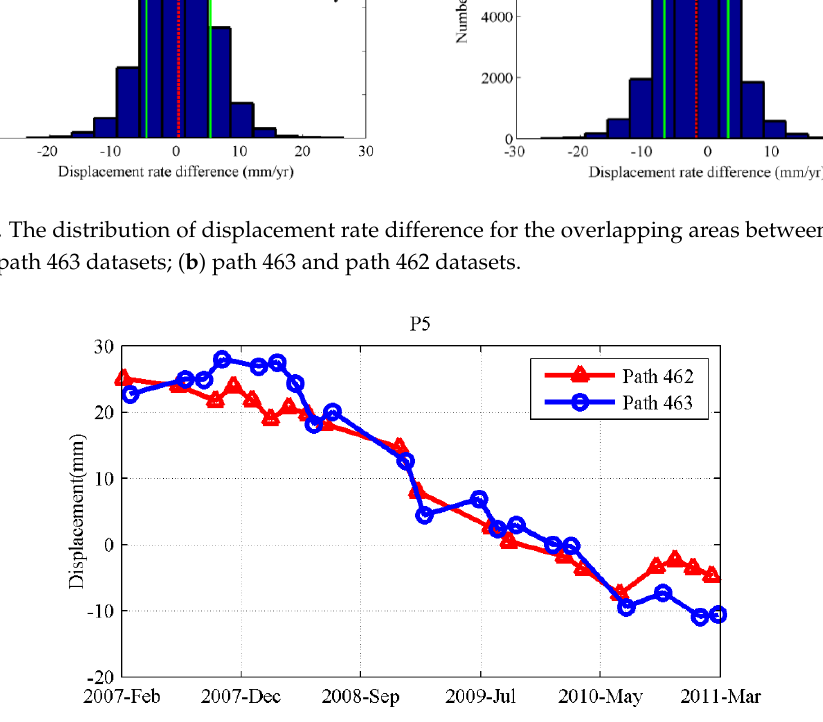
Figure 9. Time series displacement of point P5 along the slope direction located at the Huangtupo landslide.